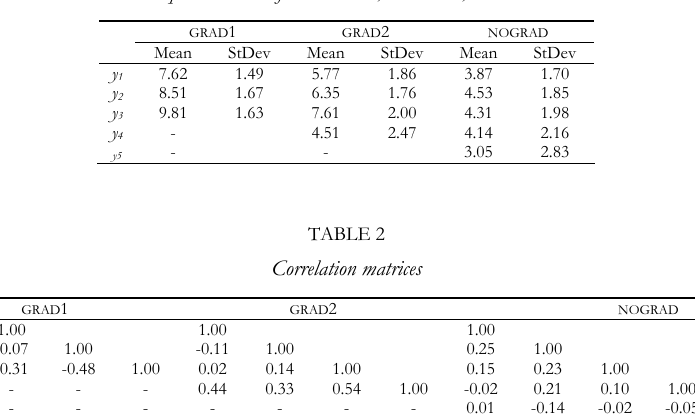
Descriptive statistics for GRAD1, GRAD2, NOGRAD